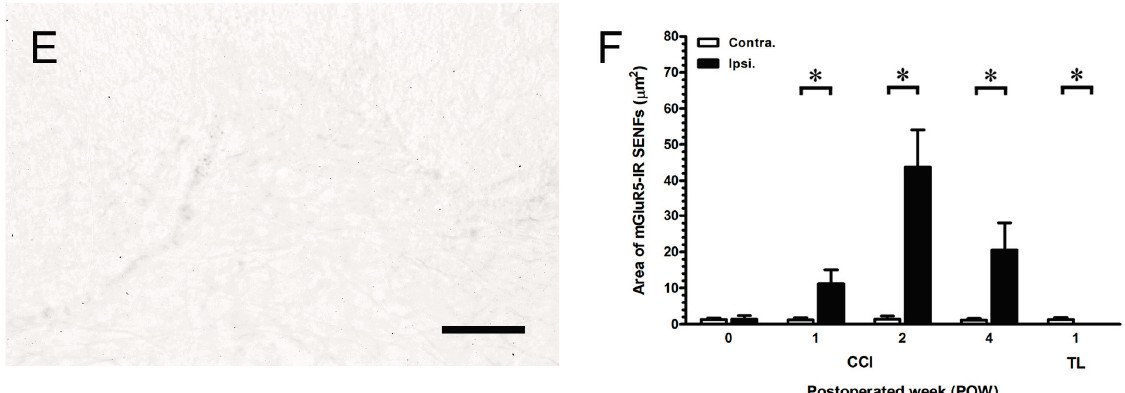
Figure 4. Cutaneous distributions of metabotropic glutamate receptor subtype 5 (mGluR5)-IR SENFs following the nerve compression injury. The ipsilateral sides of footpad from ( A ) sham-operated surgery, ( B – D ) CCI, and ( E ) TL were